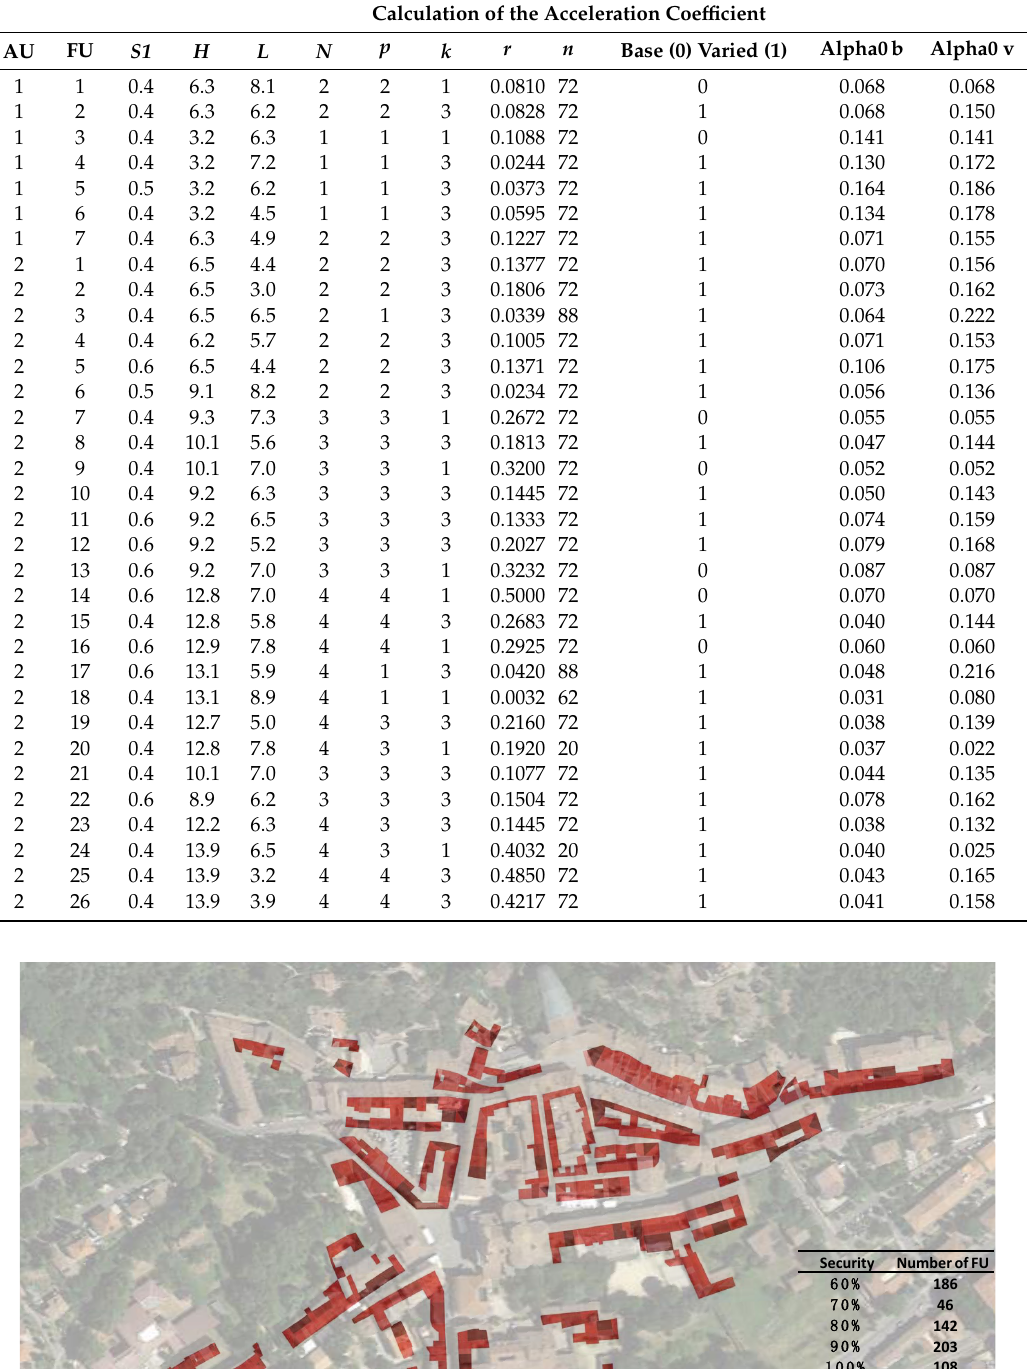
Table 1. Portion of the database displaying the calculation of the vulnerability indexes.